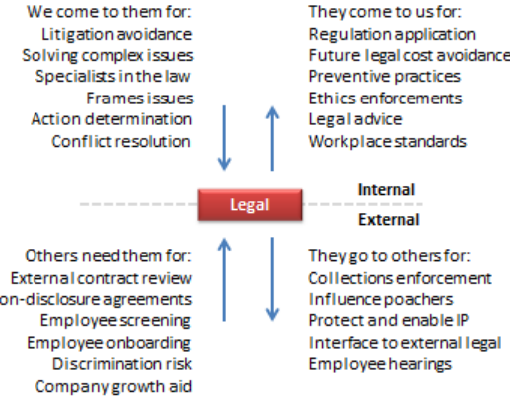
Figure 4. Domain internal and external Figure 3. Domain internal and external attributes.